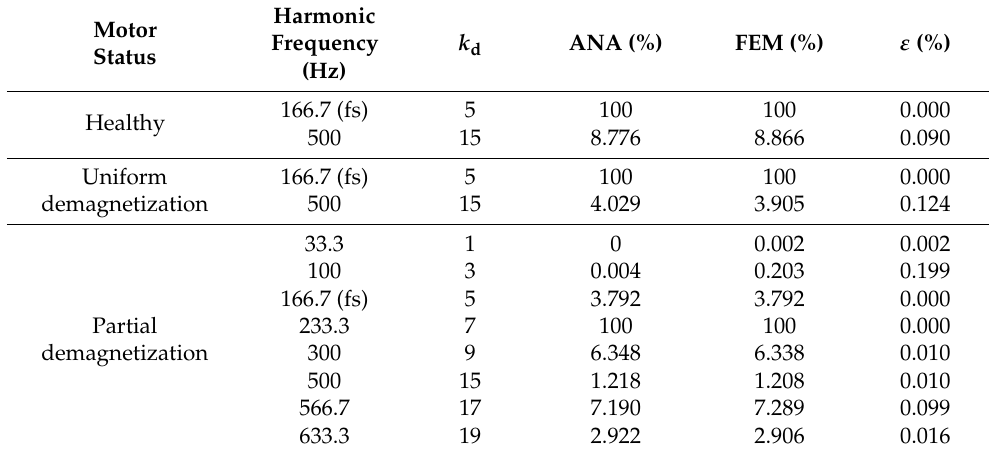
Table 4. Comparison of harmonic components of back-EMF and error.